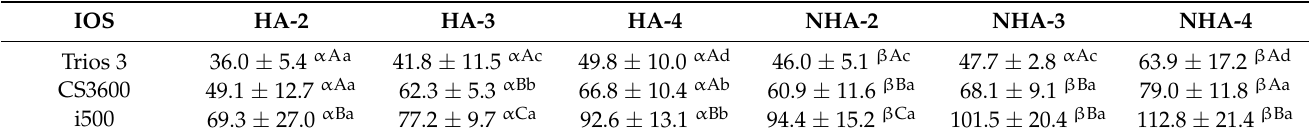
Different Greek letters indicate significant differences between the HA and NHA groups. Different uppercase letters indicate significant differences between IOSs. Different lowercase letters indicate significant differences between groups with different locations of missing teeth (HA-2 vs. HA-3 vs. HA-4, NHA-2 vs. NHA-3 vs. NHA-4) ( p <